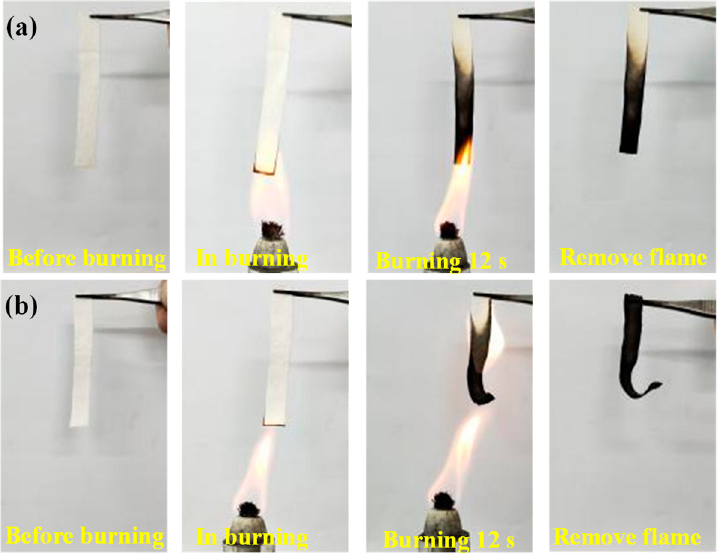
Figure 7. Combustion test optical images of CH/APP@TiO 2 -SiO 2 -HMDS (( a ). 0 laundering cycle, ( b ). 50 laundering cycles).